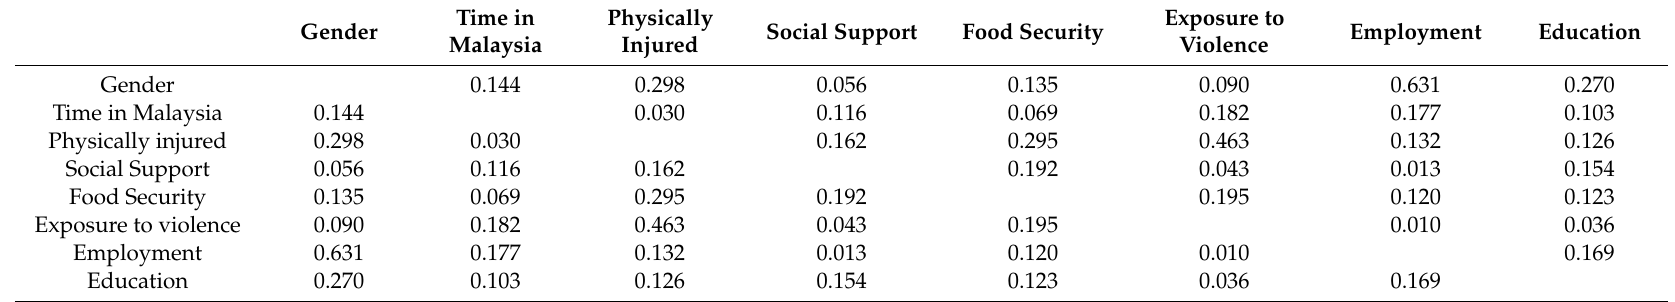
Exposure to Employment Education Violence